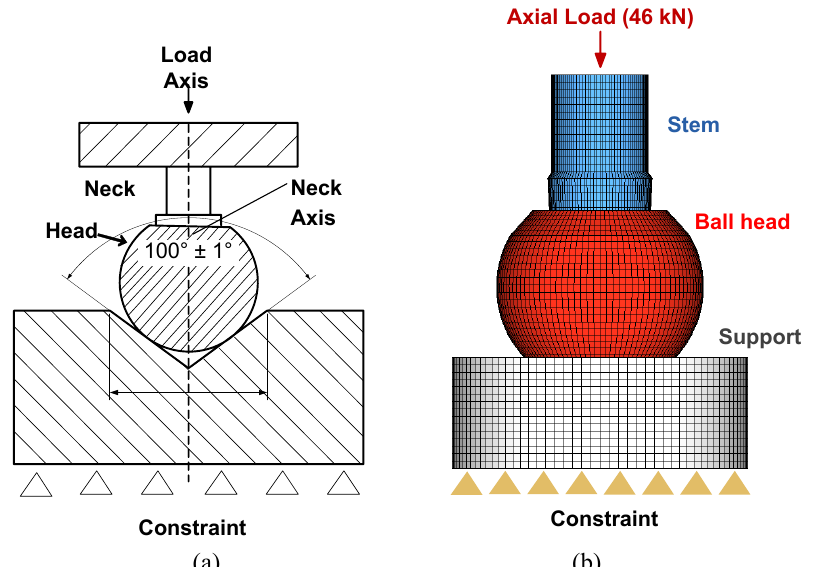
Fig. 1 Static load and boundary conditions of femoral head models. (a) ISO 7206-5 (Implants for surgery -- Partial and total hip joint prostheses -- Part 5: Determination of resistance to static load of head and neck region of stemmed femoral components) (b) Finite element analysis mesh of femoral components containing 3D 8-node brick elements. Load was applied to stem (46 kN), while support was constrained.